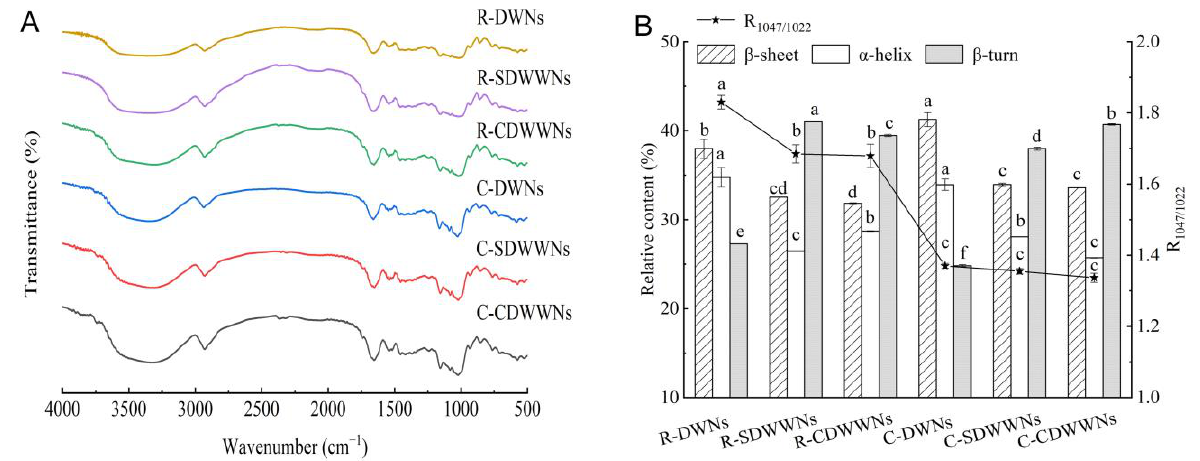
Figure 2. A. FT-IR spectra of the raw and cooked noodles; B. The changes of the secondary struc- ture of proteins and short-range ordered structure of the raw and cooked noodles. DWNs, dried wheat noodles; SDWWNs, stone-milled dried whole wheat noodles; CDWWNs, commercially dried whole wheat noodles. Different letters indicate significant differences in the same indicator data ( p < 0.05).